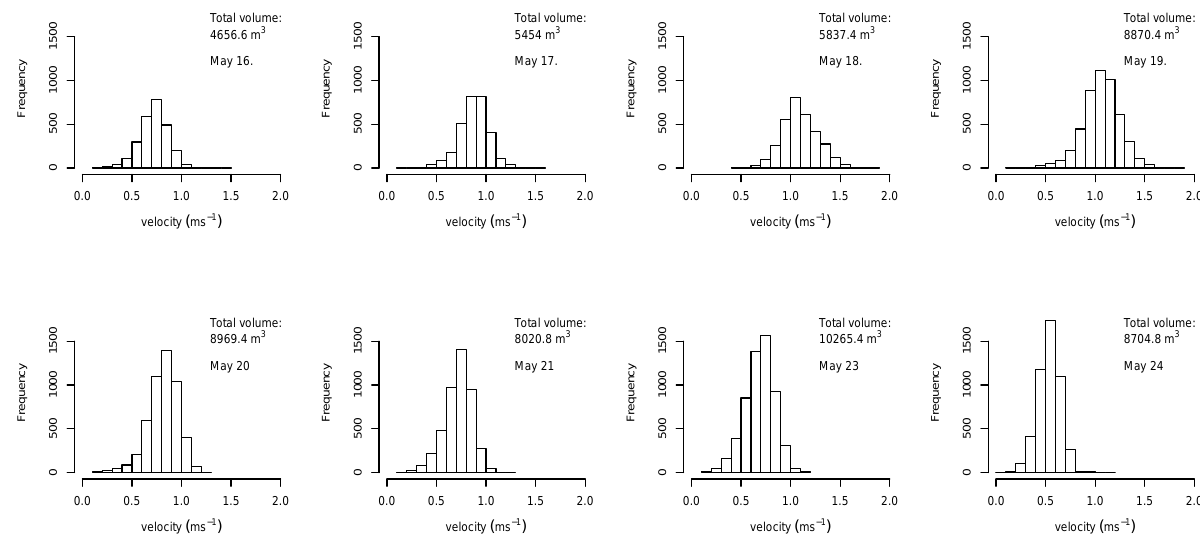
Figure 13. Histogram plots of 3D interpolated flow velocity lattice illustrating the changes in magnitude and flow speed distribution during the measurement period. All plots use the same scale. One frequency unit represents 1.8 m 3 of water, as per the 3D interpolation. Only measured volume is represented here. The top layer of water that is not captured by the ADCP, the local speeds of which are unknown, is not included in this